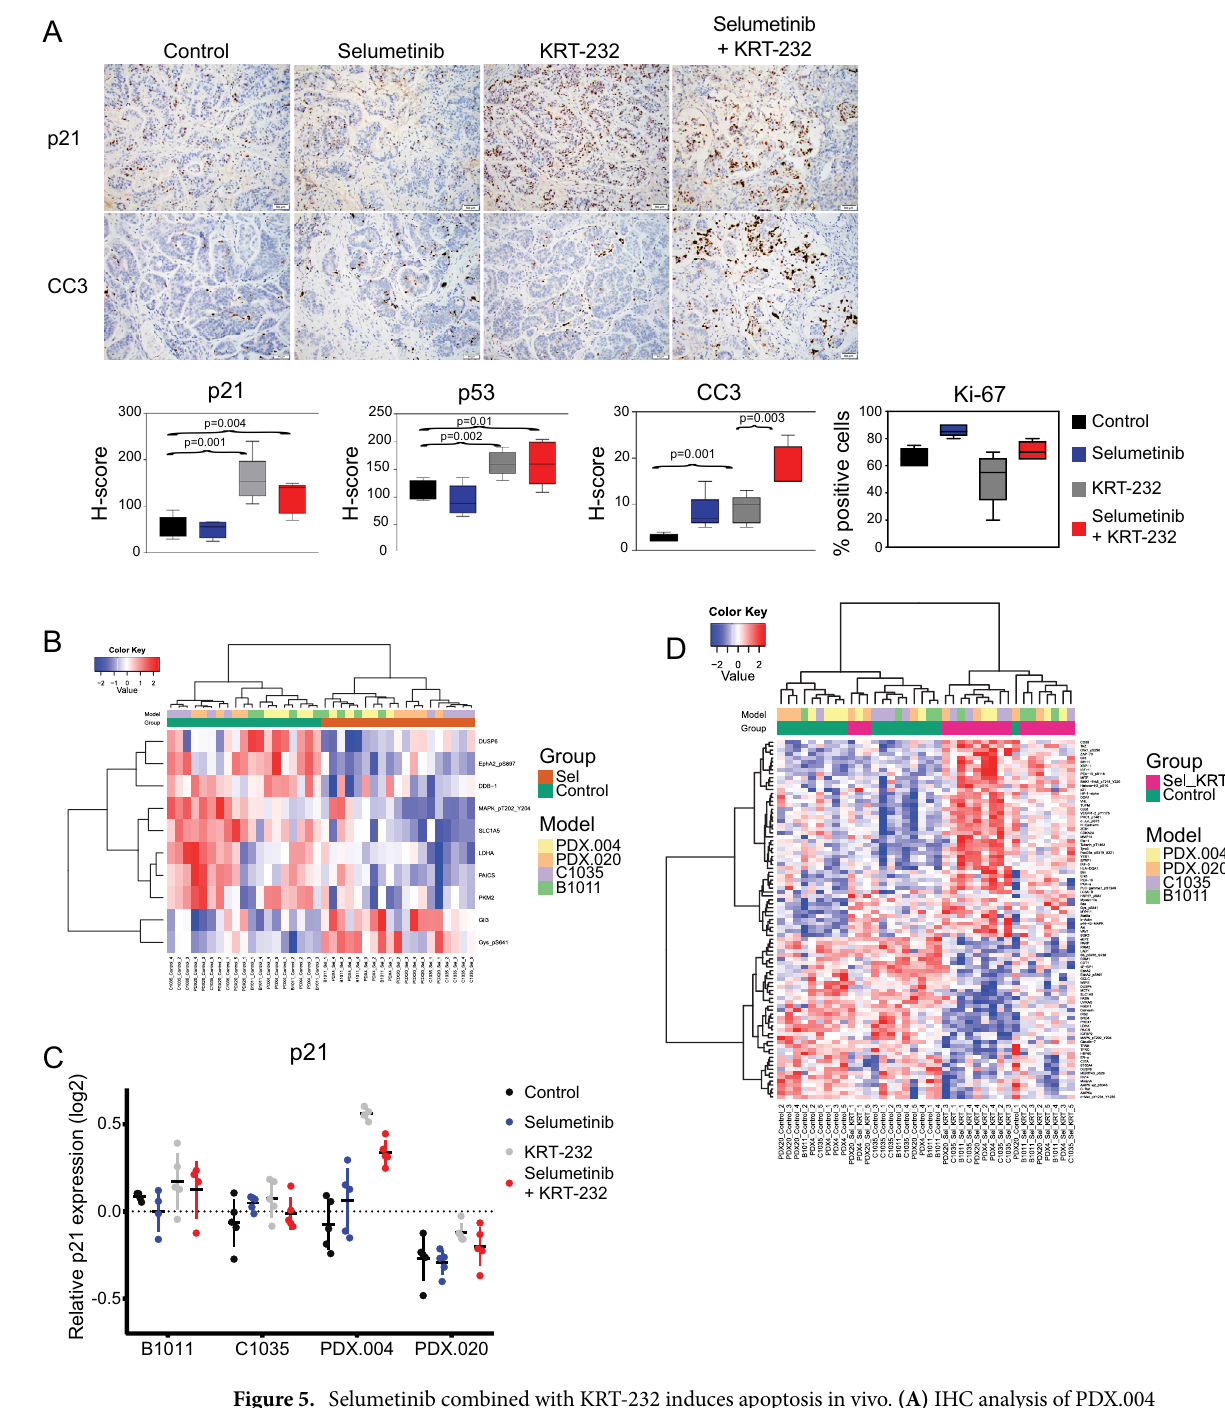
Figure 5. Selumetinib combined with KRT-232 induces apoptosis in vivo. (A) IHC analysis of PDX.004 CRC tumor samples obtained from the control, selumetinib, KRT-232, or combination treatment groups. (200 × magnification). Box plots of in vivo IHC H-score of p21, p53, and cleaved caspase 3 (CC3), and percentage of Ki-67–positive tumor cells. Values represent mean ± SD. Statistical significance was determined using the Student’s t-test. (B) Heatmap generated (with false discovery rate [FDR] 0.05) from RPPA samples obtained from selumetinib-only treated PDXs vs untreated controls demonstrated 10 differentially expressed proteins (DEPs), where samples were clustered by the treatment. (C) Scatter plot created from RPPA samples obtained from the control, selumetinib, KRT-232, or combination treatment groups demonstrating the relative expression of p21. Bars show mean ± SD. (D) Heatmap generated (with FDR 0.05) from RPPA samples obtained from PDXs treated with selumetinib plus KRT-232 vs untreated controls demonstrated 91 DEPs; samples were clustered by